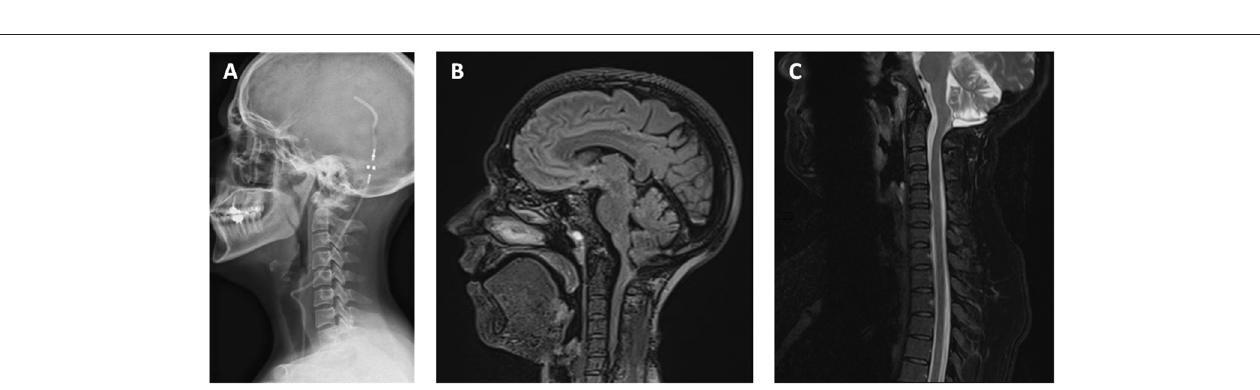
FIGURE 2 | (A) Lateral x-ray showing the ventriculoperitoneal shunt. (B) No hydrocephaly and dilatation of fourth ventricles on MRI sagittal view T1 sequence. The syrinx has completely regressed (C) on MRI sagittal view T2 sequence.